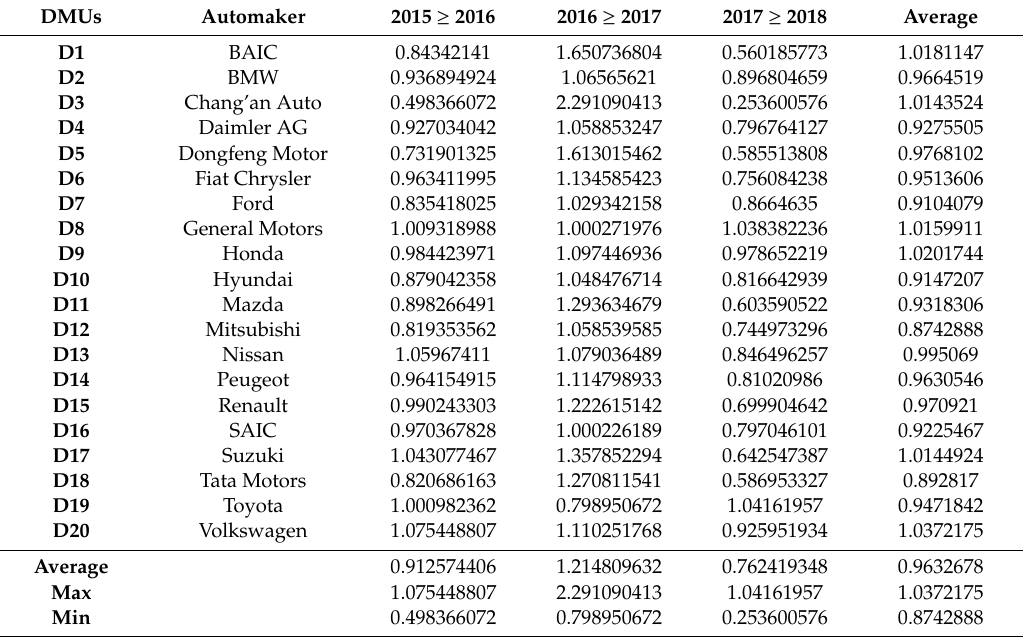
Table 6. Malmquist productivity index of the DMUs, from 2015 to